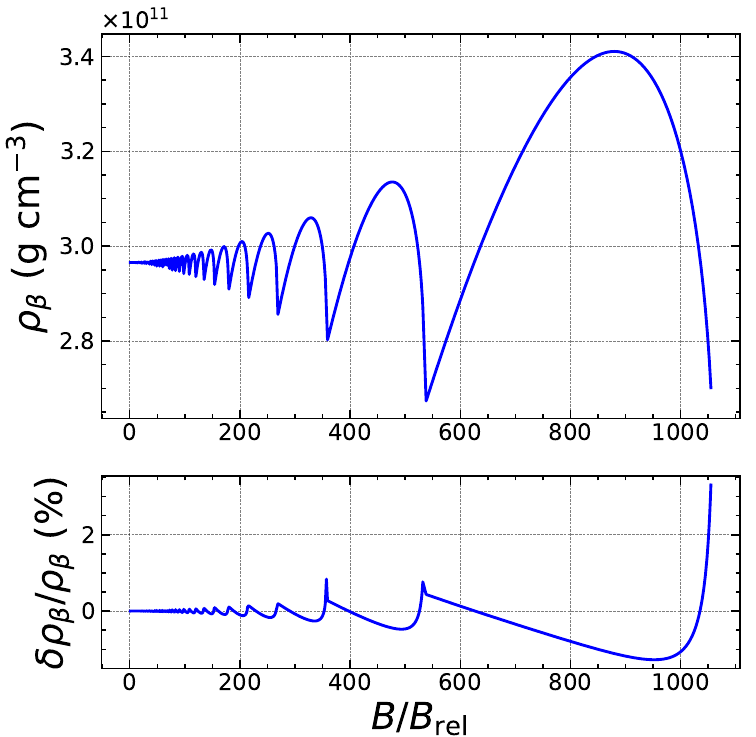
Figure 9. Top panel : Exact threshold density (in cgs units) for the onset of electron captures by 122 Zr as a function of the magnetic field strength B (cid:63) = B / B rel up to the onset of the strongly quantizing regime. Bottom panel : Relative error (in %) of the approximate analytical